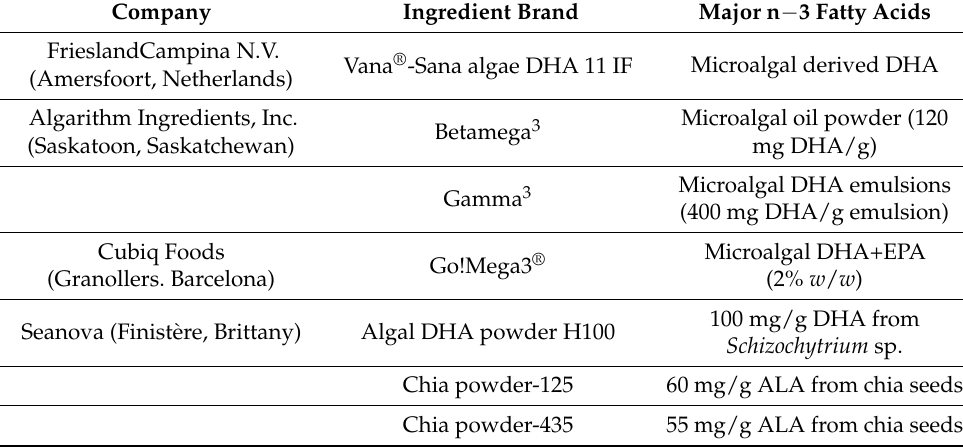
Table 2. Microencapsulated vegan n − 3 fatty acids-based commercial products. Company Ingredient Brand Major n − 3 Fatty Acids FrieslandCampina N.V. Vana ® -Sana algae DHA 11 IF Microalgal derived DHA (Amersfoort, Netherlands) Algarithm Ingredients, Inc. Microalgal oil powder (120 Betamega 3 (Saskatoon, Saskatchewan) mg DHA/g) Microalgal DHA emulsions Gamma 3 (400 mg DHA/g emulsion) Cubiq Foods Microalgal DHA+EPA Go!Mega3 ® (Granollers. Barcelona) (2% w / w ) 100 mg/g DHA from Seanova (Finist è re, Brittany) Algal DHA powder H100 Schizochytrium sp. Chia powder-125 60 mg/g ALA from chia seeds Chia powder-435 55 mg/g ALA from chia